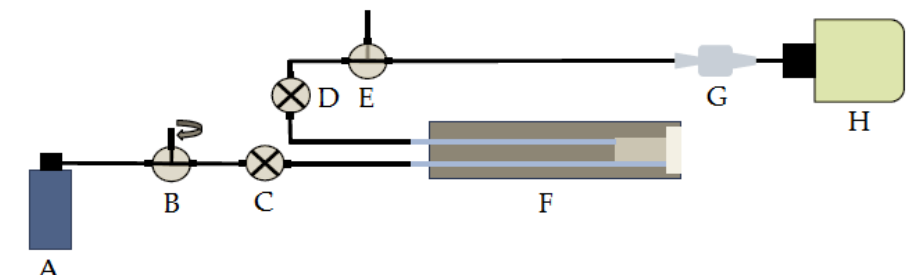
Figure 9. Diagram of experimental apparatus for material irradiation and isotope collection, illustrating a (A) target gas tank and regulator, (B) flow control valve, (C) target load valve, (D) target unload valve, (E) delivery/waste valve, (F) target body and target material, (G) soda lime carbon dioxide trap, and (H) radioisotope gas collection bag.